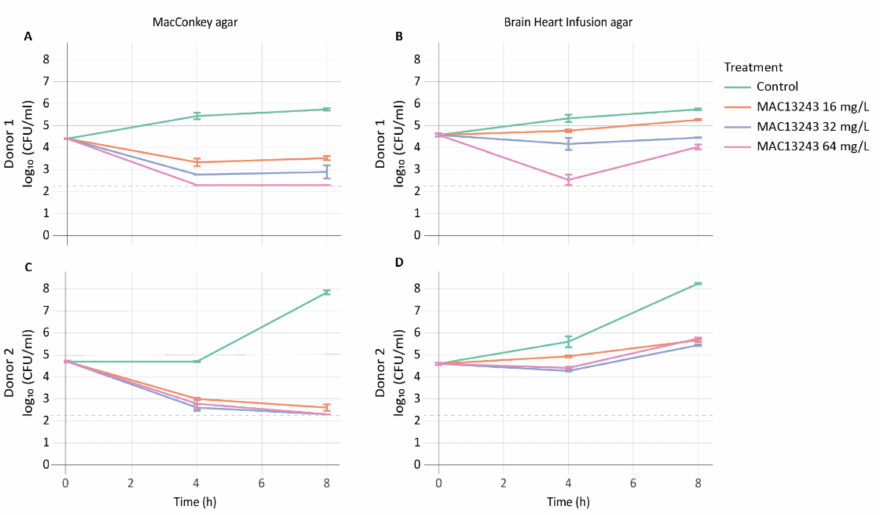
Figure 1. Viable cell counts of coliforms on MacConkey agar ( A , C ), and of total bacteria on Brain Heart Infusion agar ( B , D ) in faecal samples from two human donors after exposure to MAC13243. The limit of detection (200 CFU/mL) is highlighted with a dashed